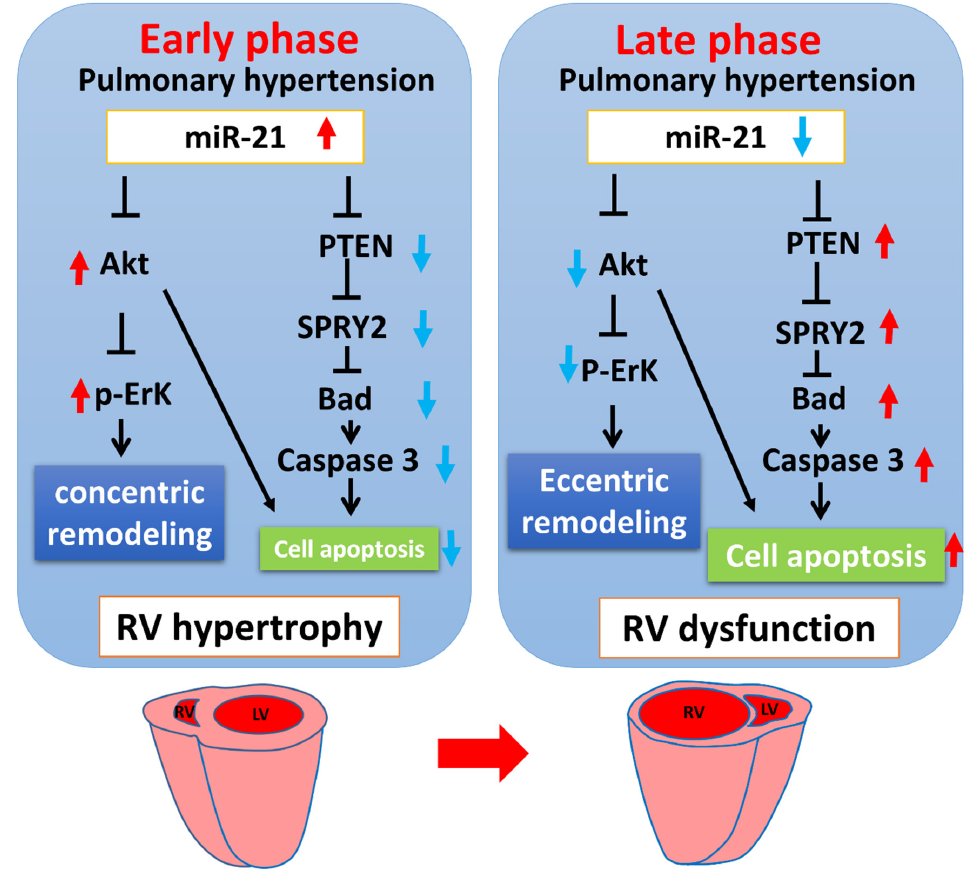
Figure 8. The summary of MiR-21 regulation in the process from RV hypertrophy (early phase) to dysfunction (late phase) under pulmonary hypertension. The up-regulation of miR-21 in the early phase (RV hypertrophy) and down-regulation in the late phase (RV dysfunction) under PAH consequently triggered a biphasic regulation of cardiac remodeling and cell apoptosis.